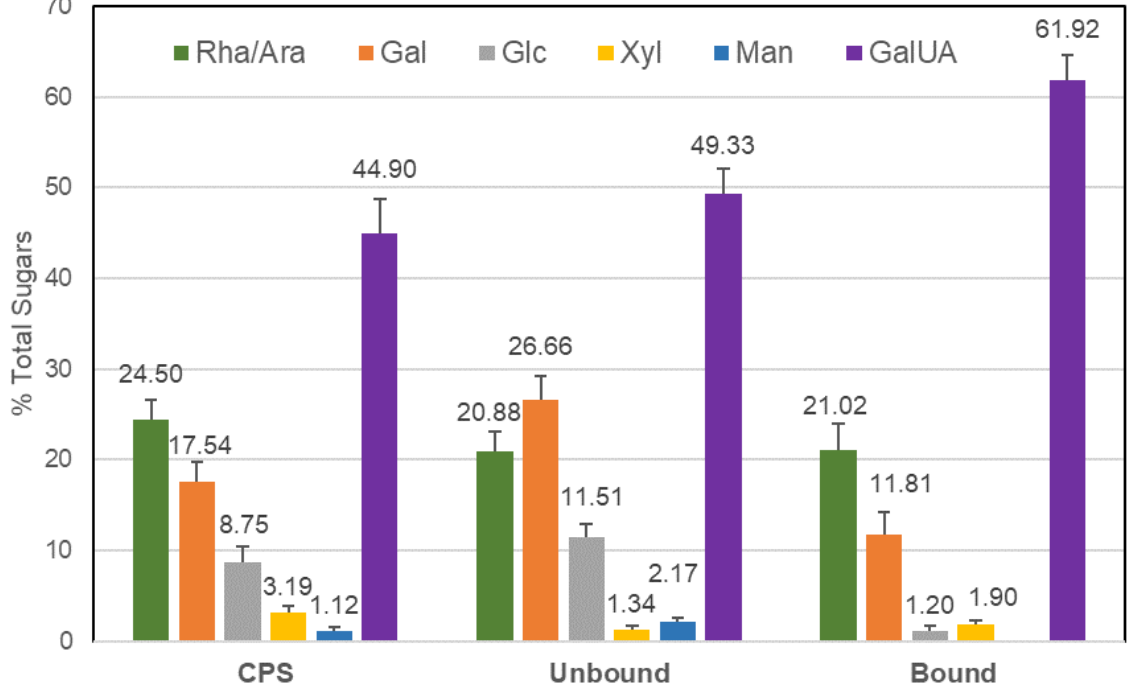
Figure 1. Monosaccharide composition of the crude polysaccharide fraction (CPS), the unbound fraction (UNBOUND), and the bound fraction (BOUND), following anion exchange purification. Percentages of total monosaccharide content are shown ( ± SE, n = 4 for CPS and 6 for unbound and bound). The BOUND fraction was enriched in galacturonic acid and contained galactose, arabinose, and rhamnose. The BOUND sample had reduced amounts of glucose, galactose, xylose, and mannose compared to the CPS, which indicated the removal of neutral polysaccharides by the ion exchange procedure.